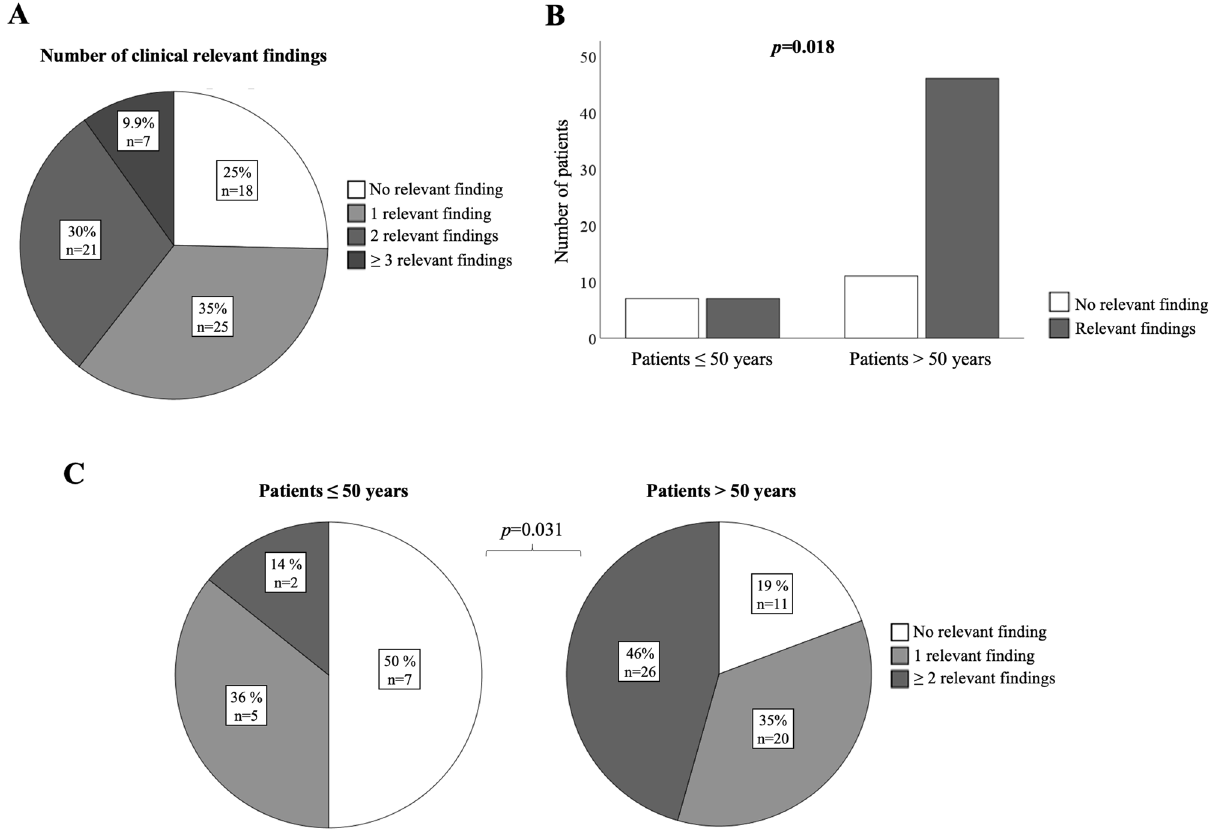
Figure 1. Incidental findings of the MADE-PVI cohort prior to PVI. ( A ) Clinically relevant incidental findings prior to PVI occurred in 53 out of 71 patients (74.6%). Out of these patients, 25 patients suffered from one incidental finding, while 21 and 7 patients suffered from 2 or more clinically relevant incidental findings, respectively. Shown is the proportion / number of patients with clinically relevant incidental findings. ( B ) Clinically relevant incidental findings were detected significantly more frequently in patients aged older than 50 years compared to younger patients ( p = 0.018). ( C ) Patients aged older than 50 years had a distinctly higher risk for more than one pathology of the upper gastrointestinal tract compared to younger patients ( p = 0.031). Shown is the number ( B ) and proportion ( C ) of patients with clinically relevant incidental